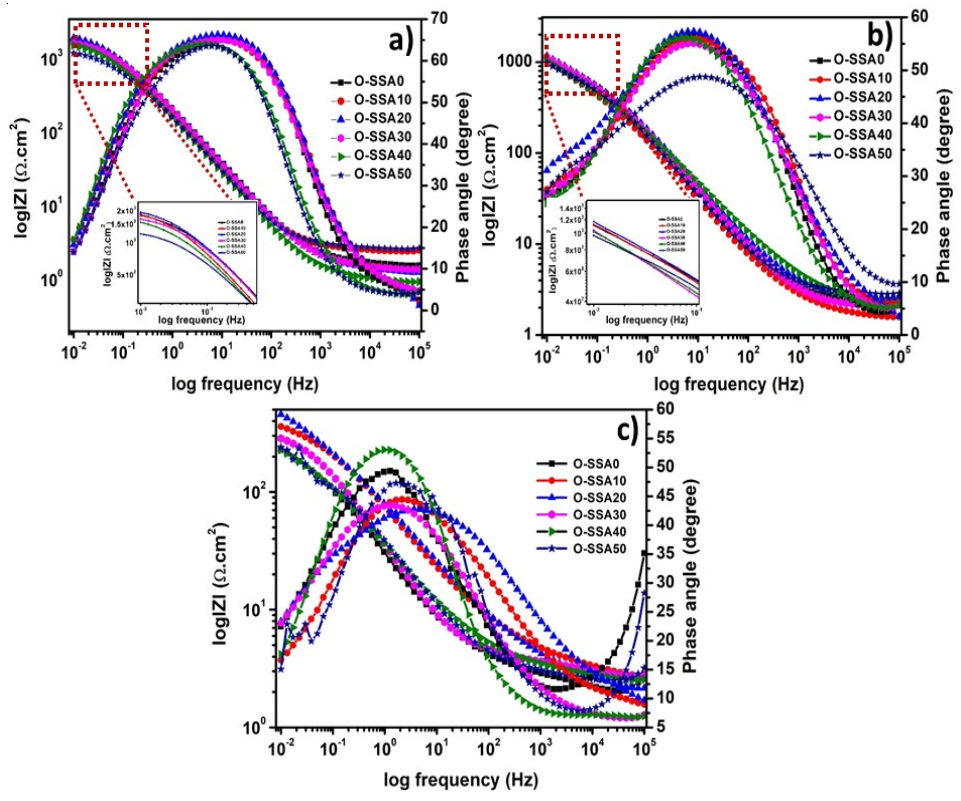
Figure 9. EIS − Bode plots for steel rebars in chloride contaminated various cement extracts for an exposure period of 1 day ( a ); 15 days ( b ); and 30 days ( c ). exposure period of 1 day ( a ); 15 days ( b ); and 30 days ( c